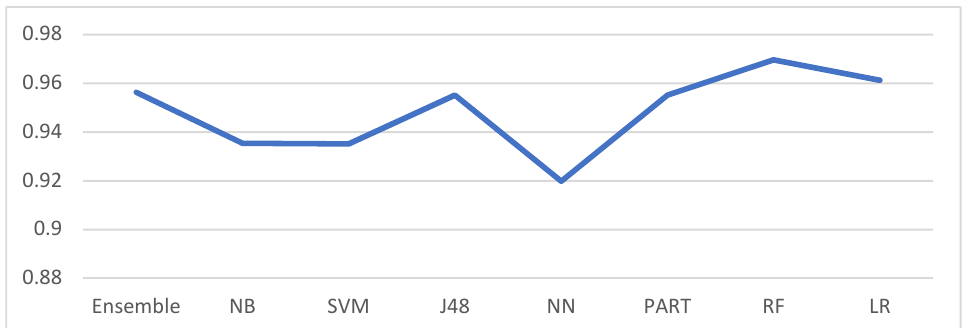
Figure 3. Kappa statistics of experimented classifiers against ensemble model.